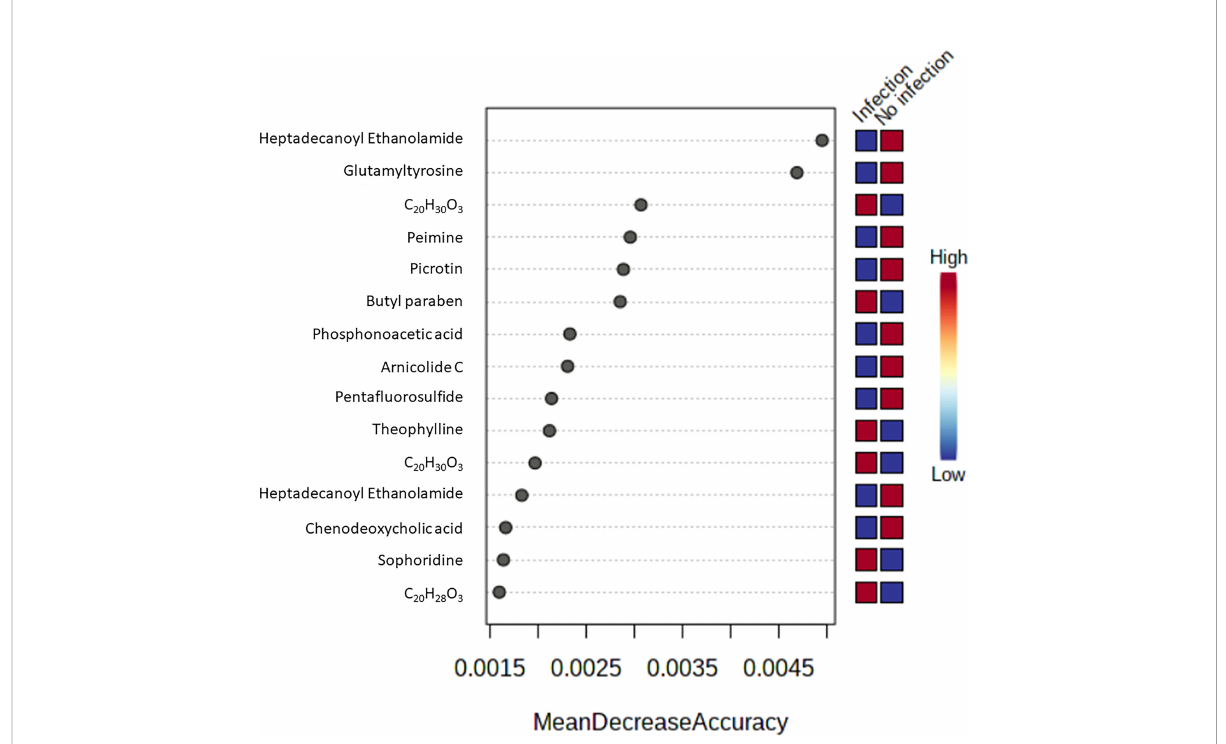
FIGURE 5 Top 15 metabolites with highest mean decrease accuracy from feature important detection with random forest